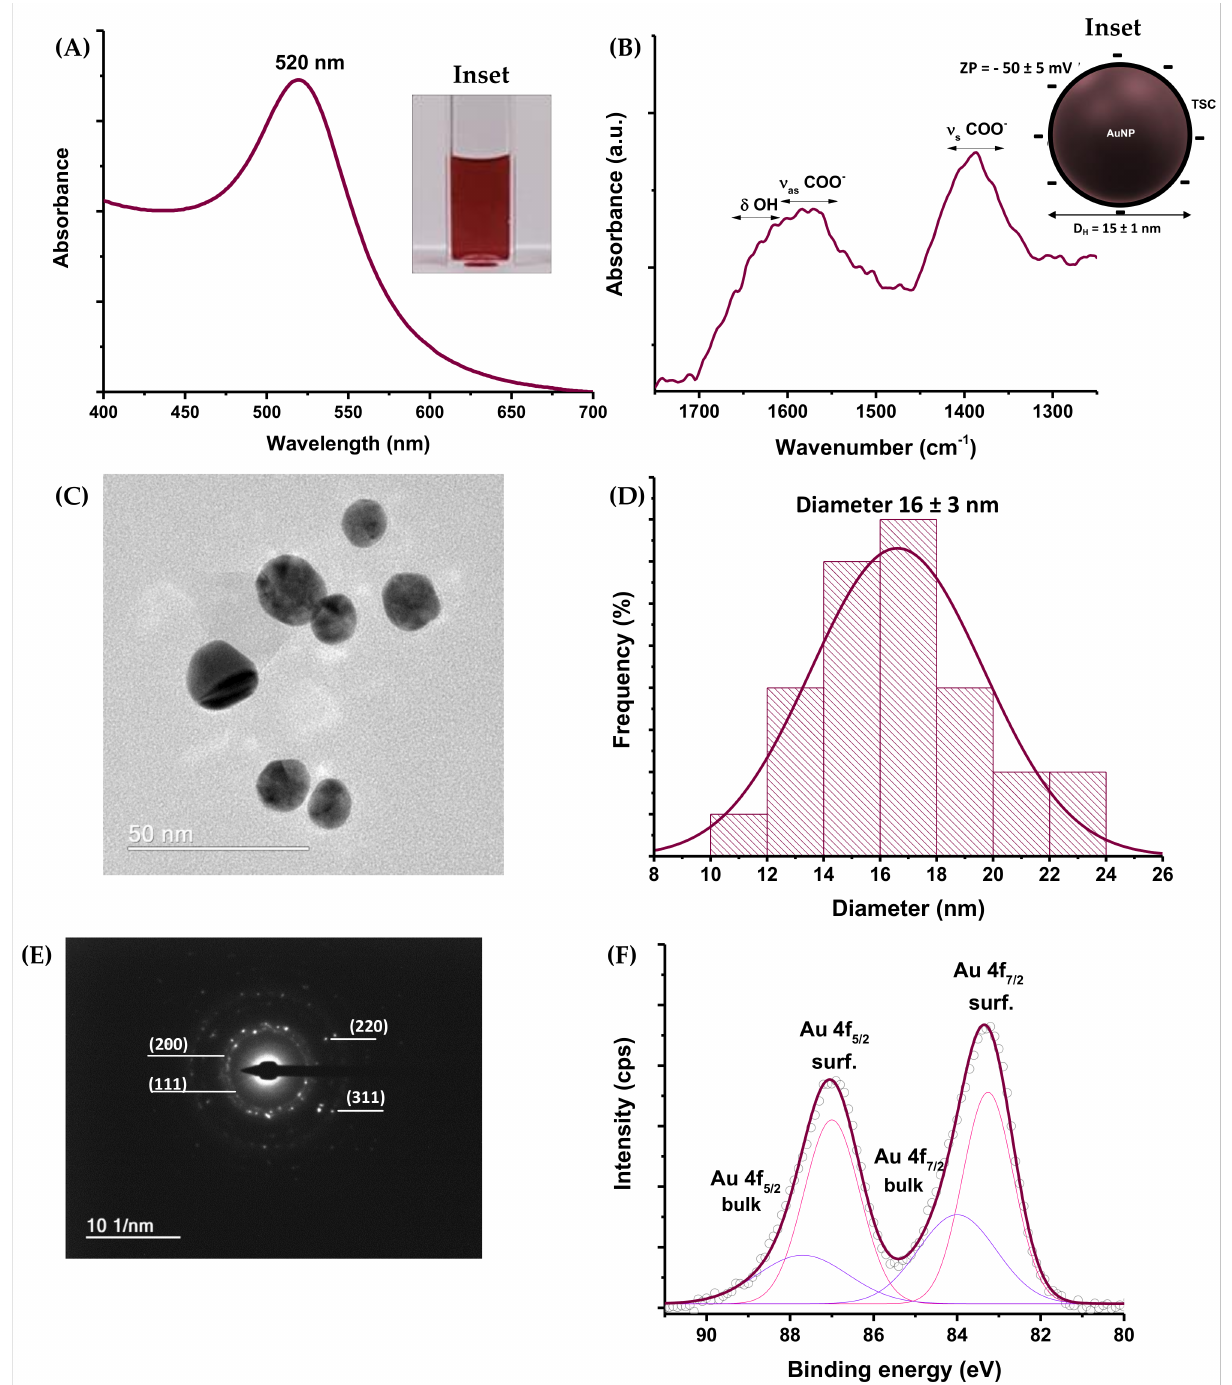
Figure 3. Characterization of AuNPs: ( A ) UV–Vis spectrum (inset: digital image of colloidal sus- pension). ( B ) FTIR and schematic representation of ZP and D H (inset). ( C ) Nanoparticle image and ( D ) size distribution histogram based on TEM analysis. ( E ) SAED image with diffraction planes. ( F ) HR-XPS spectrum of the Au 4f